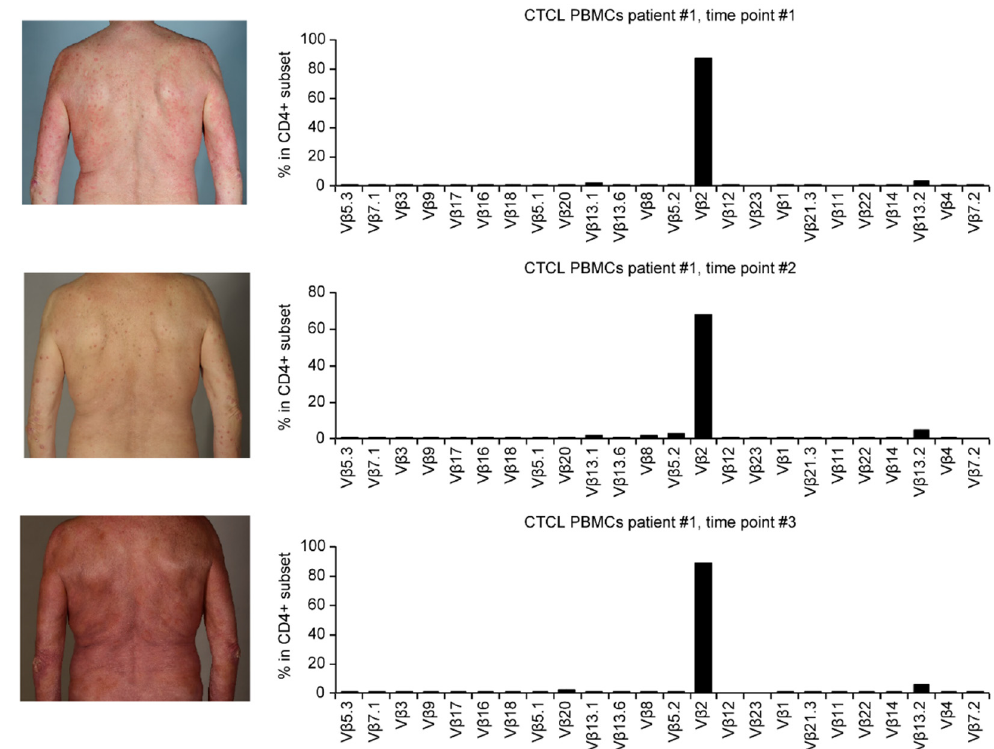
Figure 3. Time course and continuous detection of the same TCR Vbeta2 during the course of the disease. In blood cells from a CTCL patient over one year, the tumour cells express the TCR at the cell surface (FACS analysis), and no downregulation of this molecule was observed. There are six months between the time points. Between time point #1 and time point #2 the patient received immunomodulatory treatment by interferon-alpha that resulted in complete regression of skin lesions. Between time point #2 and time point #3 the patient received no therapy (“watchful waiting”) and relapsed.